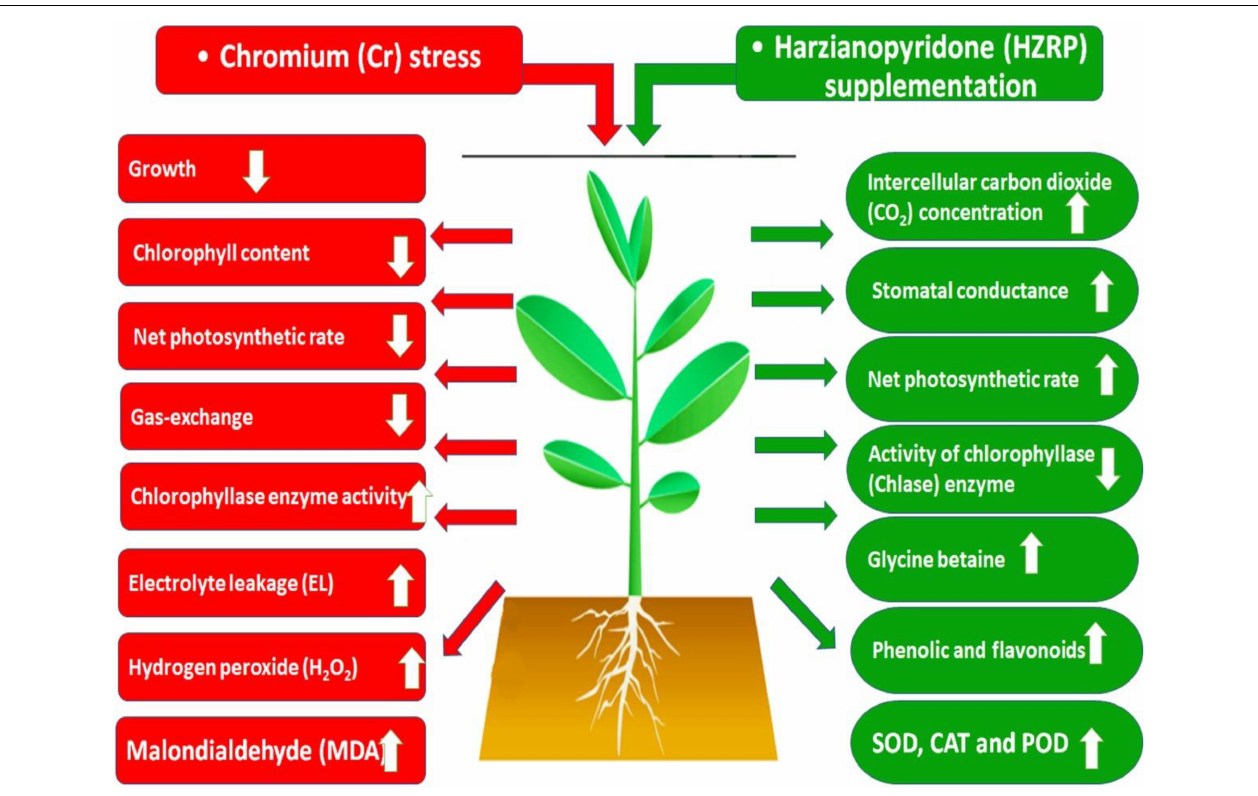
FIGURE 6 | Schematic model explaining the role of HZRP in alleviation of Cr stress in V. radiata